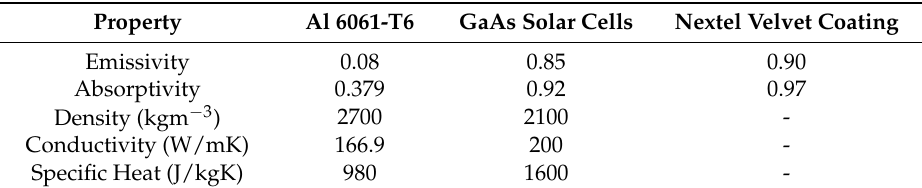
Table 28. Material Properties Outer Face Materials